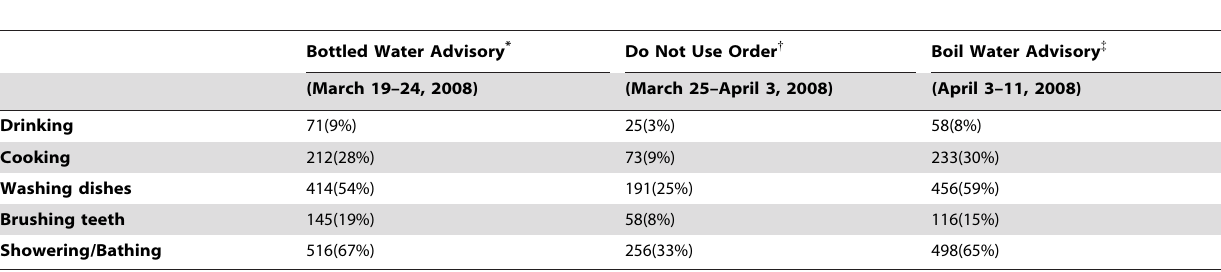
Table 4. Number and percent of households that reported using any tap water for the following purposes during the various water advisories (n= 771 households) associated with an outbreak of salmonellosis, Alamosa, Colorado 2008.